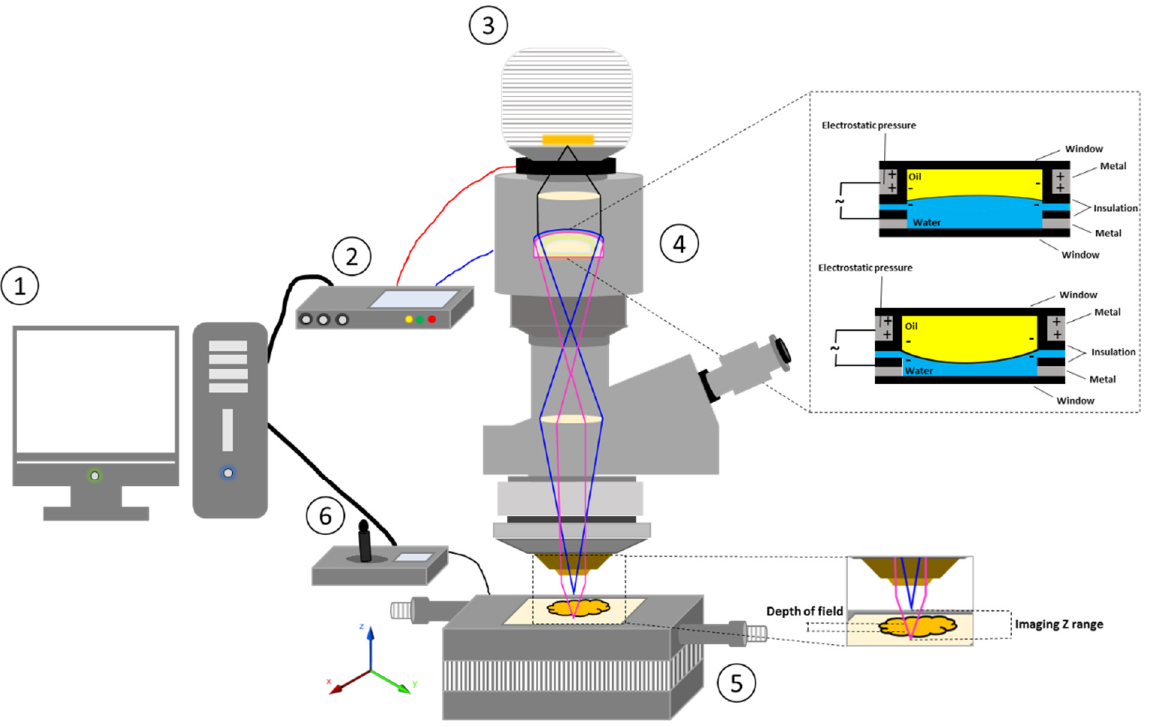
Figure 1. Schematic illustration of ETL-based imaging system. (1) computer; (2) ETL driver; (3) camera; (4) ETL; (5) automatic motorized vertical translation stage; and (6) stage controlling system. Table 1. Specifications of electrically tunable lens integrated add-on camera system.